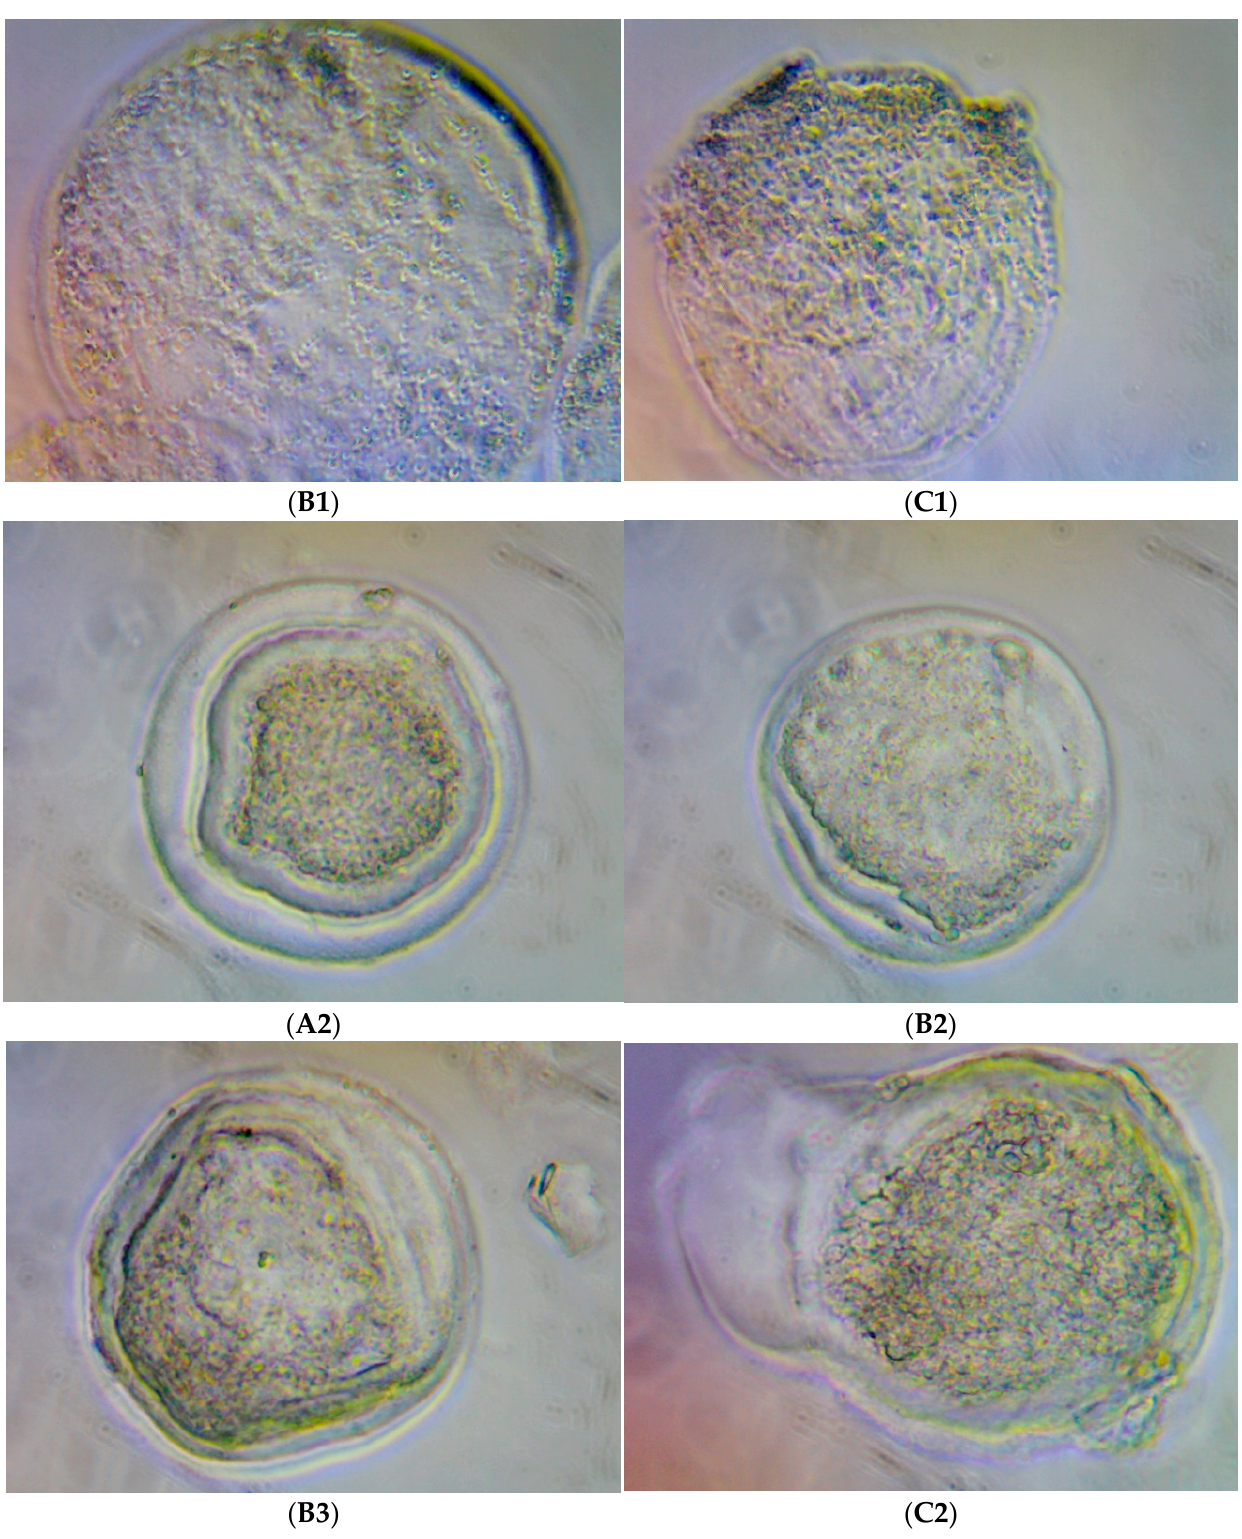
Figure 4. Illustrations from the contrast microscope at 200 × magnification: ( B1 ) expanded blastocyst from Experiment 1; ( C1 ) hatched blastocyst from Experiment 1; ( A2 ) blastocyst from Experiment 2; ( B2 , B3 ) expanded blastocysts from Experiment 2; ( C2 ) hatched blastocyst from Experiment 2; all DAB-stained in vitro bovine embryos were cultivated with 2 µg/mL of rHGAL-1 supplementation (Group 2).